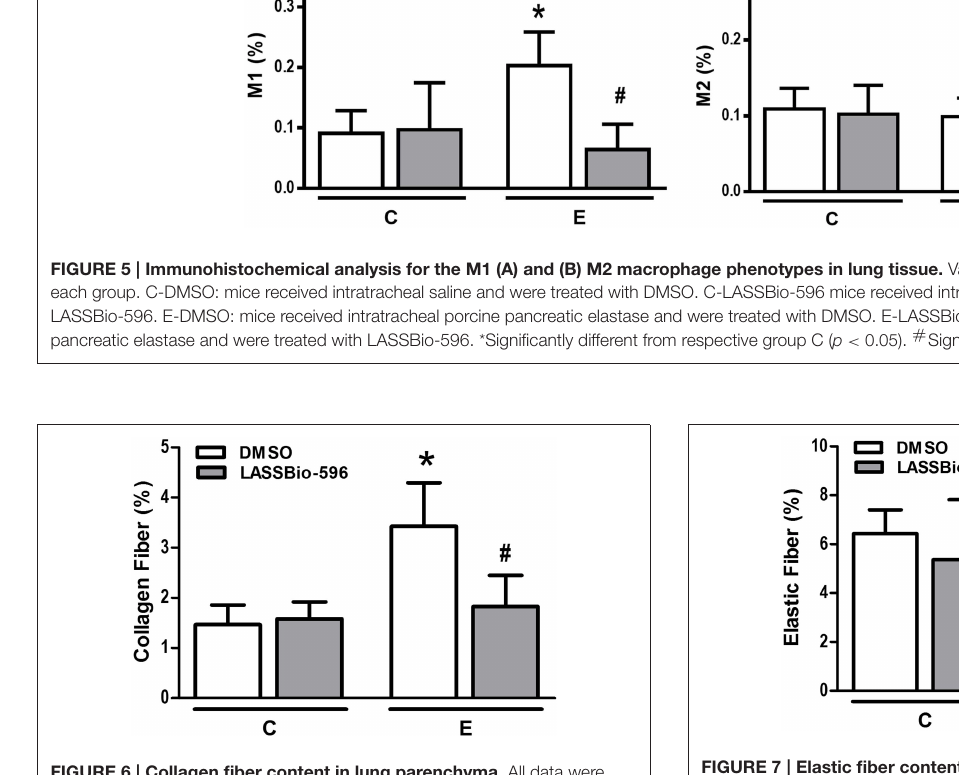
FIGURE 6 | Collagen fiber content in lung parenchyma. All data were collected in 10 random, non-coincident fields per mouse. Values are means ( ± SD) of six animals in each group. C-DMSO: mice received intratracheal saline and were treated with DMSO. C-LASSBio-596 mice received intratracheal saline and were treated with LASSBio-596. E-DMSO: mice received intratracheal porcine pancreatic elastase and were treated with DMSO. E-LASSBio-596: mice received intratracheal porcine pancreatic elastase and were treated with LASSBio-596. * Significantly different from respective group C ( p < 0.05 ). # Significantly different from E-DMSO ( p < 0.05 ).